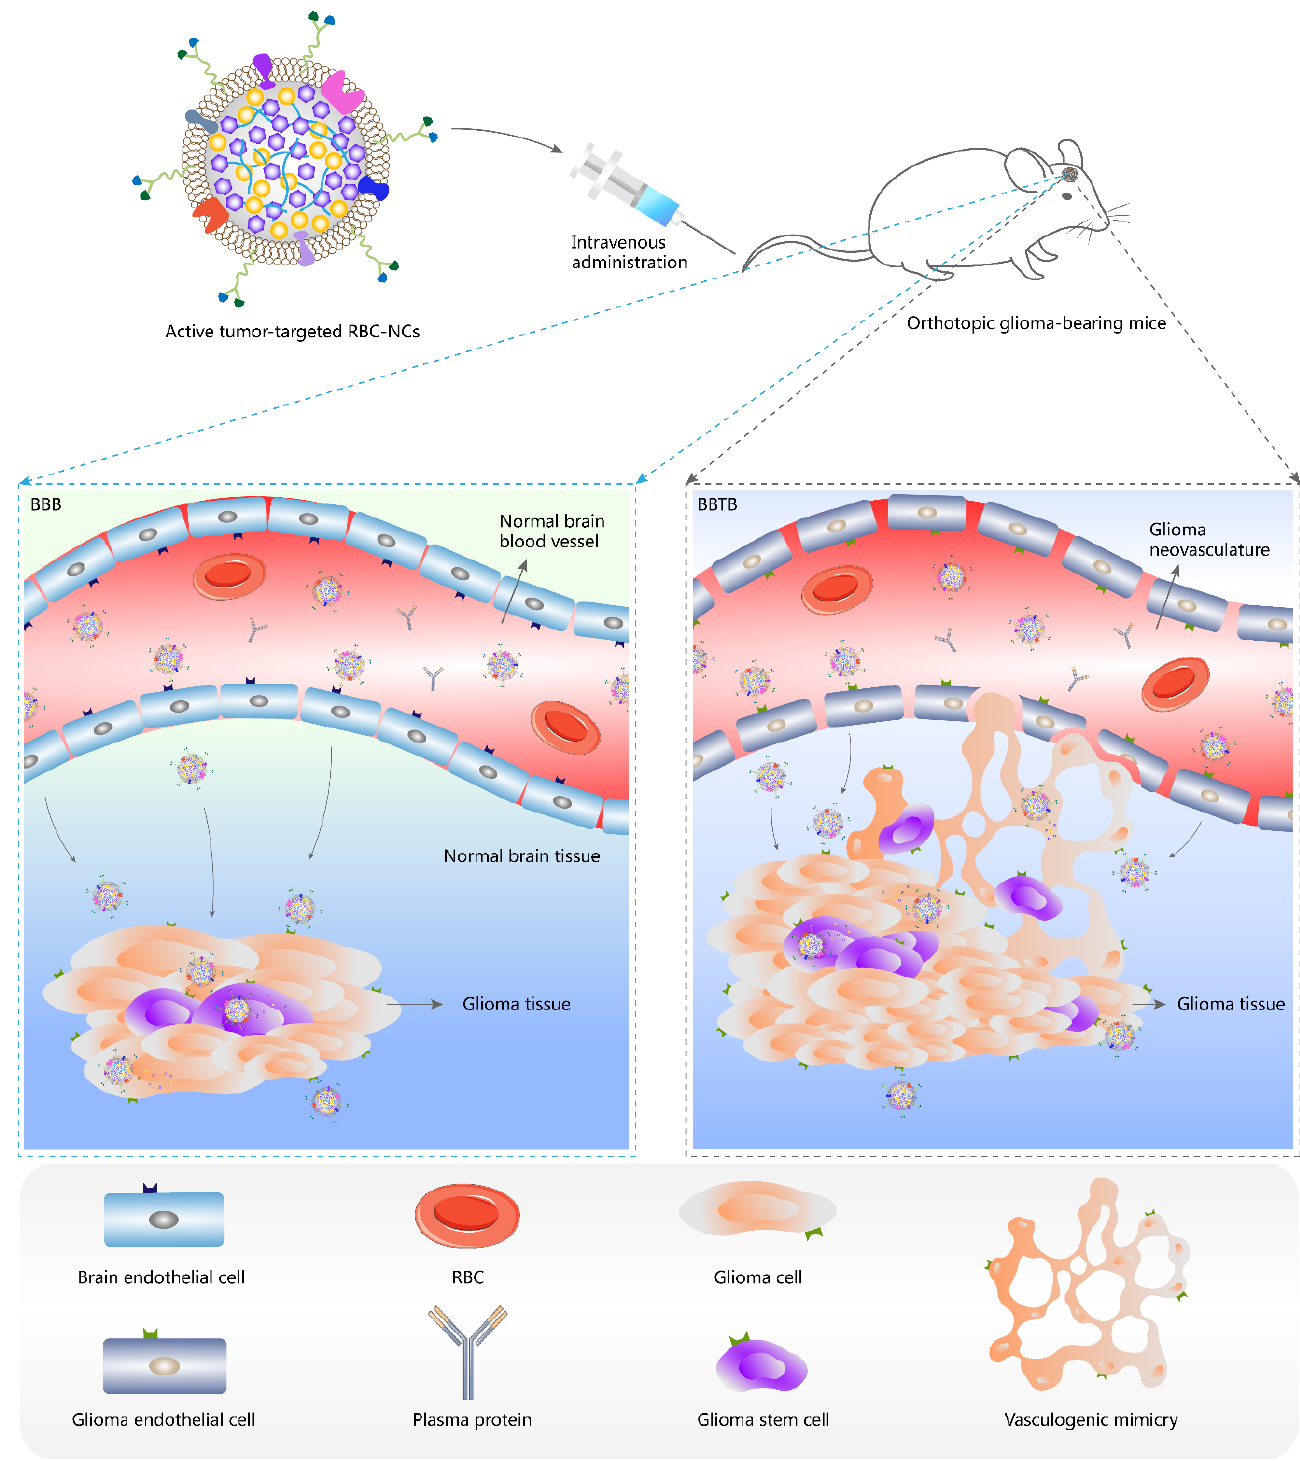
Figure 1. Schematic illustration of active tumor-targeted drug NCs that penetrate BBB and BBTB, and target glioma in vivo. BBB, blood-brain barrier; BBTB, blood-brain tumor barrier; NCs, nanocrystals; RBC, red blood cell; RBC-NCs, red blood cell membrane-coated drug nanocrystals.